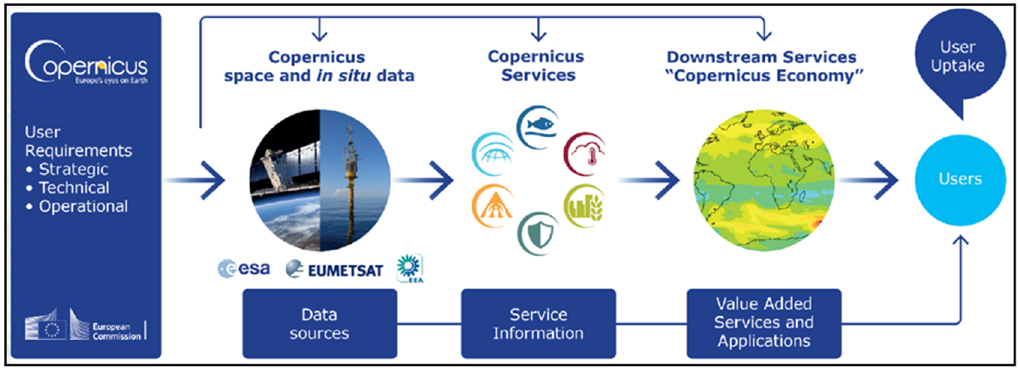
Figure 1. Copernicus user-oriented strategy (after the European Copernicus website). 187